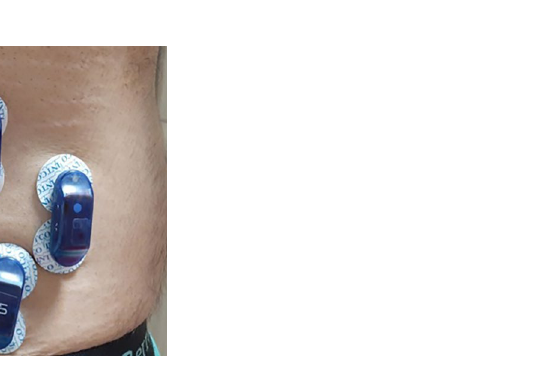
Figure 2. Placement of EMG electrodes on back